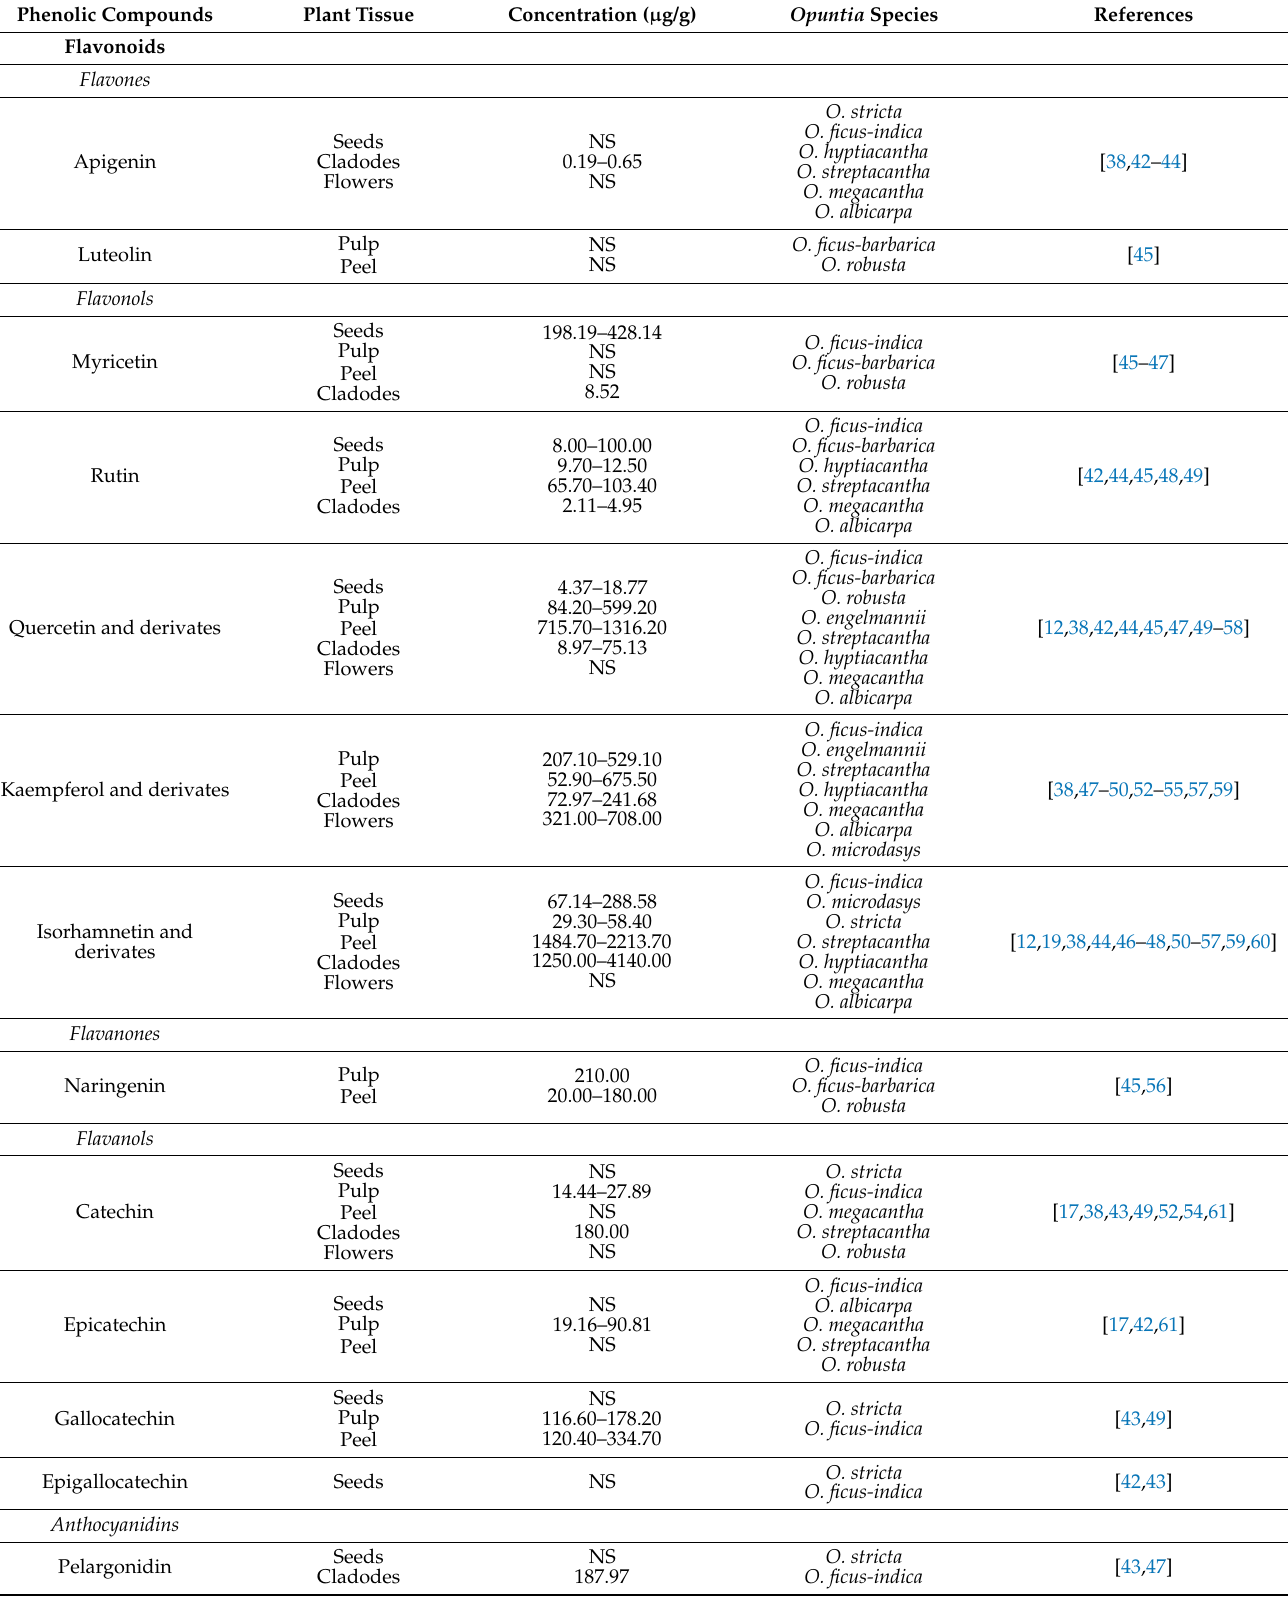
Table 1. Phenolic compounds reported in the different vegetative parts of the genus Opuntia 1